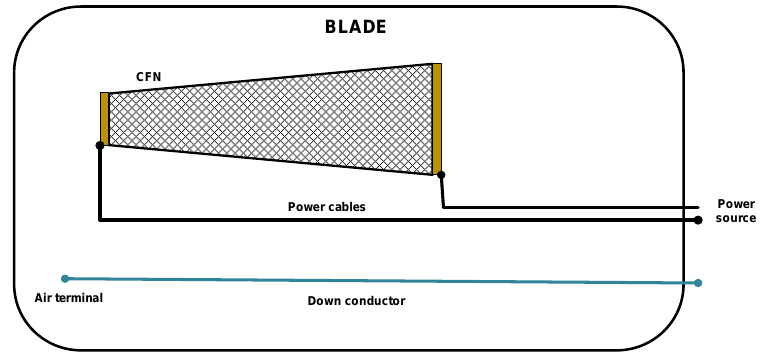
Figure 2. Configuration of down-conductor and electrical heating system.